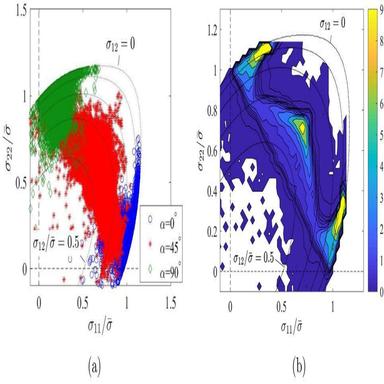
Distribution of the experimental stress states and Yld2000-2D yield surface (a) and corresponding probability density function contour plot (b).